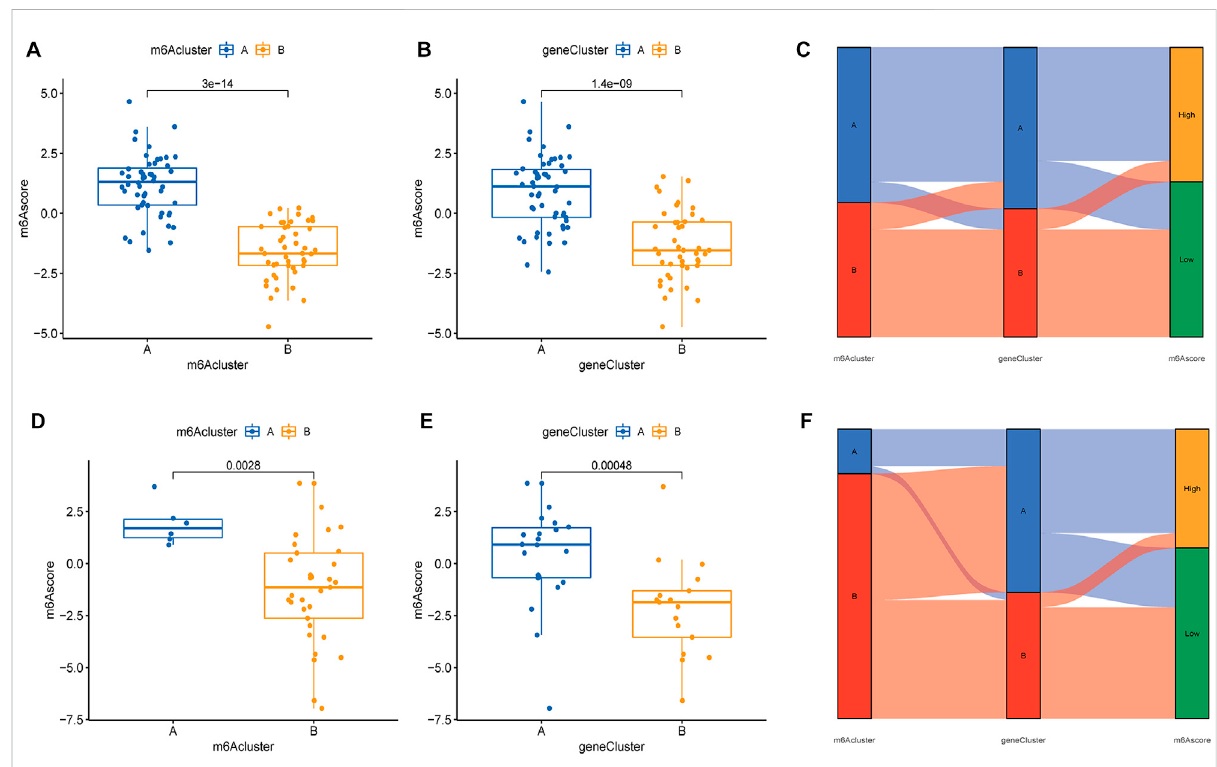
FIGURE 8 Differential analysis of m6A scores in the two typing methods based on the GSE16129 and GSE30119 datasets. Differential analysis of m6A scores in the two m6A subgroups (A) and two gene subgroups (B) based on the GSE16129. (C) A Sankey diagram was showed the relationship between m6A subgroups, m6A gene subgroups, and m6A scores based on the GSE16129. Differential analysis of m6A scores in the two m6A subgroups (D) andtwogenesubgroups (E) basedontheGSE30119. (F) ASankeydiagramwasshowedtherelationshipbetweenm6Asubgroups, m6A gene subgroups, and m6A scores based on the